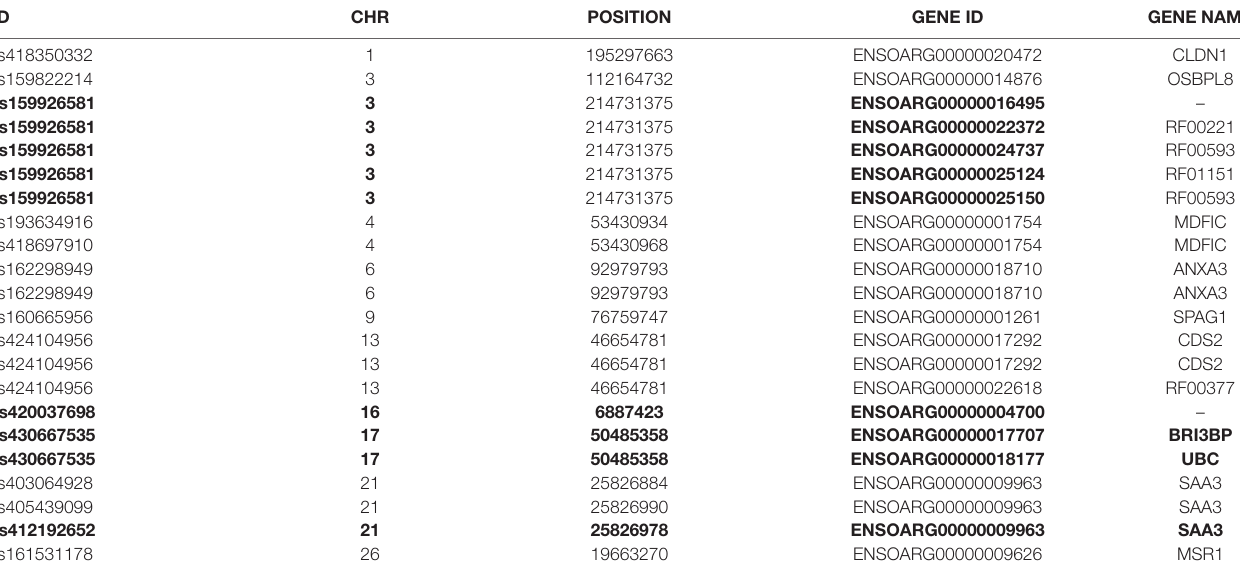
TABLE 3 | The variant IDs of LPS-inducible ASE SNVs (Fisher’s exact) and their respective genes. Data were obtained using Ensembl BioMart query builder. Highly significant SNVs are highlighted in bold [false discovery rate (FDR), < 1×10 -8 ]. ID CHR POSITION GENE